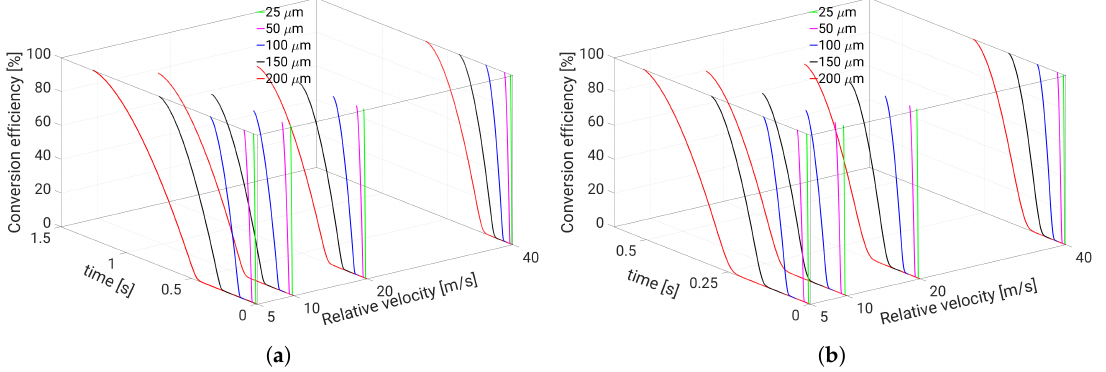
Figure 9. Conversion efficiency with respect to various diameter and relative velocity for: ( a ) T g = 573 K; ( b ) T g = 773 K.